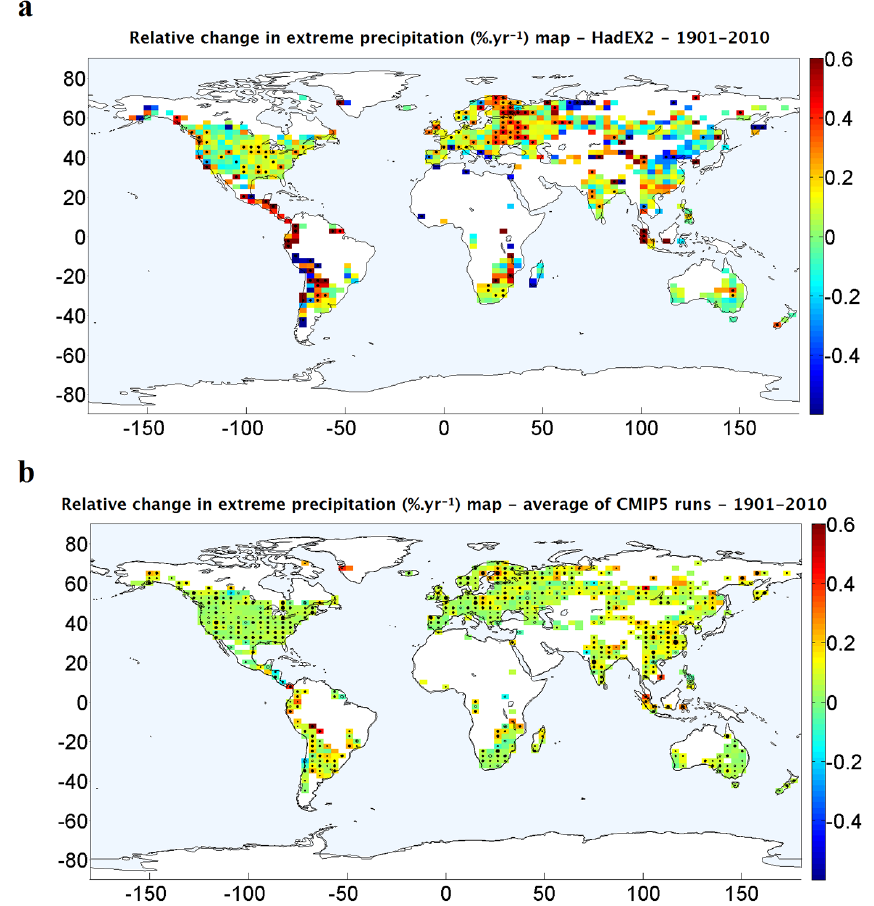
Figure 5. HadEX2 observational data versus CMIP5 averaged results of global extreme precipitation in 1901–2010 – relative change in annual-maximum daily precipitation (%yr − 1 ) map for (a) HadEX2 and (b) the average of CMIP5 model runs. Stippling indicates significance of the calculated trend at the 95% confidence level. In cases of CMIP5 average maps, filled/empty stippling indicates a positive/negative trend on average. The larger marker size means a larger number of models agreeing on the presented trend, with the largest one indicating only 7 out of 19 model runs agreeing on the presented trend